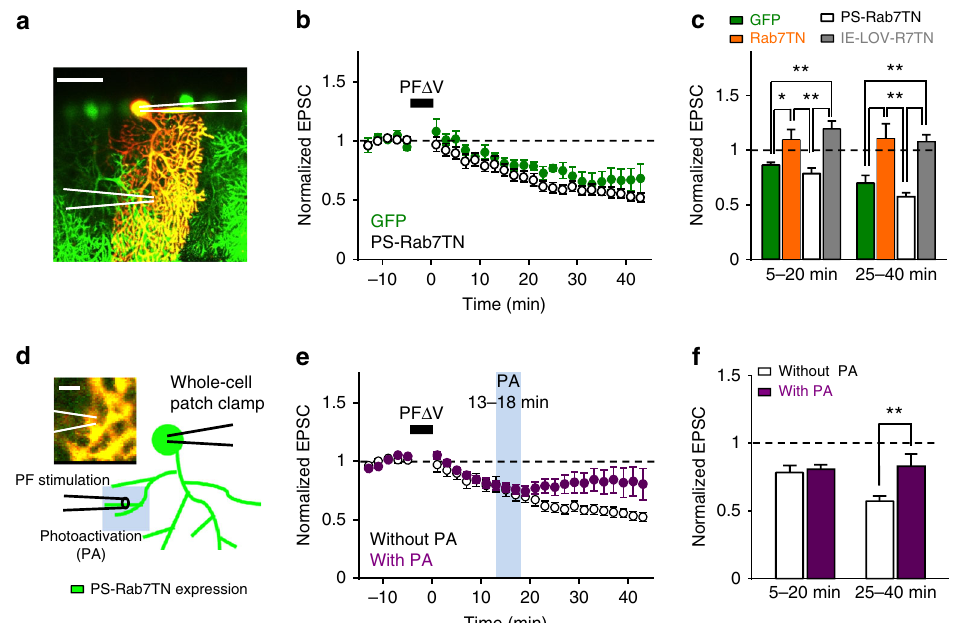
Fig. 5 Interruption of LTD upon the photoactivation of PS-Rab7TN. a An image of a PC expressing PS-Rab7TN ( green ) and containing Alexa568 ( red ) introduced through a patch pipette. The positions of the patch pipette ( right ) and the stimulation electrode ( left ) are shown with white lines . Scale bar : 50 μ m. b Time course of LTD induced by PF Δ V in PCs expressing PS-Rab7TN without photoactivation ( open circles , n = 10). For comparison, the time course of LTD in cells expressing GFP shown in Fig. 3e are overlaid ( green circles ). c Average amplitudes of normalized PF-EPSCs calculated at 5 – 20 min or 25 – 40 min after the end of PF Δ V. IE-LOV-R7TN: IE-LOV-Rab7TN-546-2. d The design of experiments using blue laser photoactivation ( PA ). Photoactivation was applied around the PC dendrites, where the stimulation electrode is placed. Scale bar : 5 μ m. e Time course of LTD in PCs expressing PS-Rab7TN with photoactivation at 13 – 18 min ( light blue column ) after the end of PF Δ V ( purple circles , n = 11). Control LTD without photoactivation shown in b is overlaid ( open circles ). f Comparison of normalized PF-EPSCs calculated at 5 – 20 min or 25 – 40 min after the end of PF Δ V between with and without photoactivation at 13 – 18 min in PCs expressing PS-Rab7TN. * P < 0.05, ** P < 0.01, two-way ANOVA followed by the Fisher ’ s LSD test. Exact P values for the data sets in this fi gure are provided in Supplementary Table